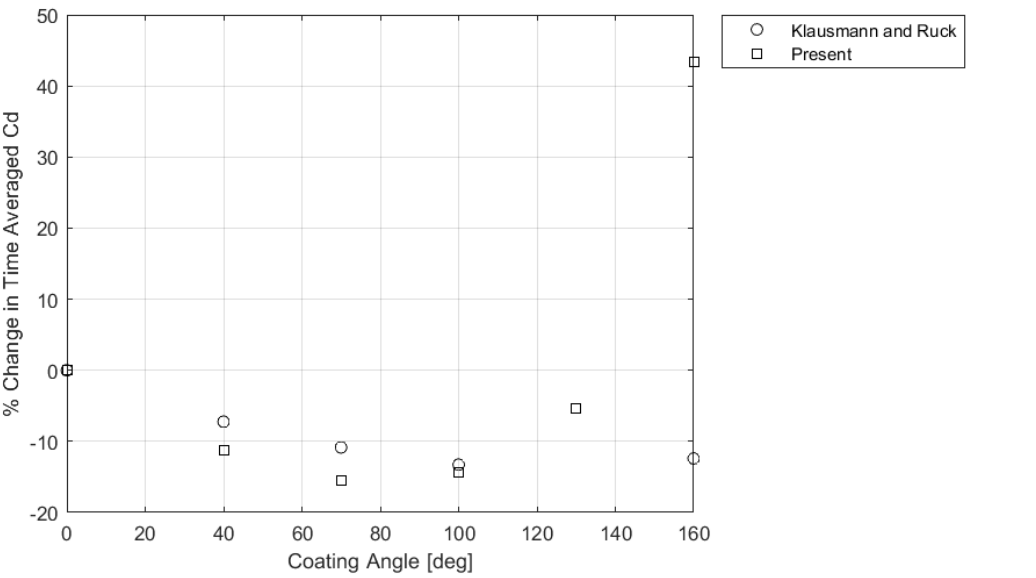
Figure 6. Percentage change in the time-averaged drag coefficient with porous coating angle β compared to the experimental results adapted from Klausmann and Ruck [25]. Constant porosity of 20 PPI and coating thickness t / D =